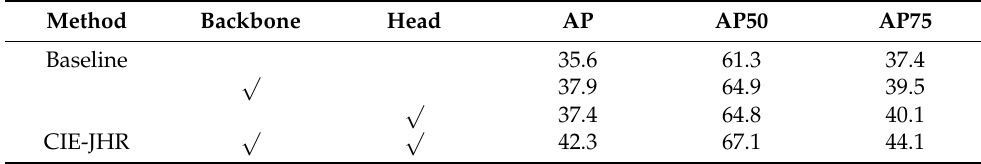
Table 6. The results of ablation